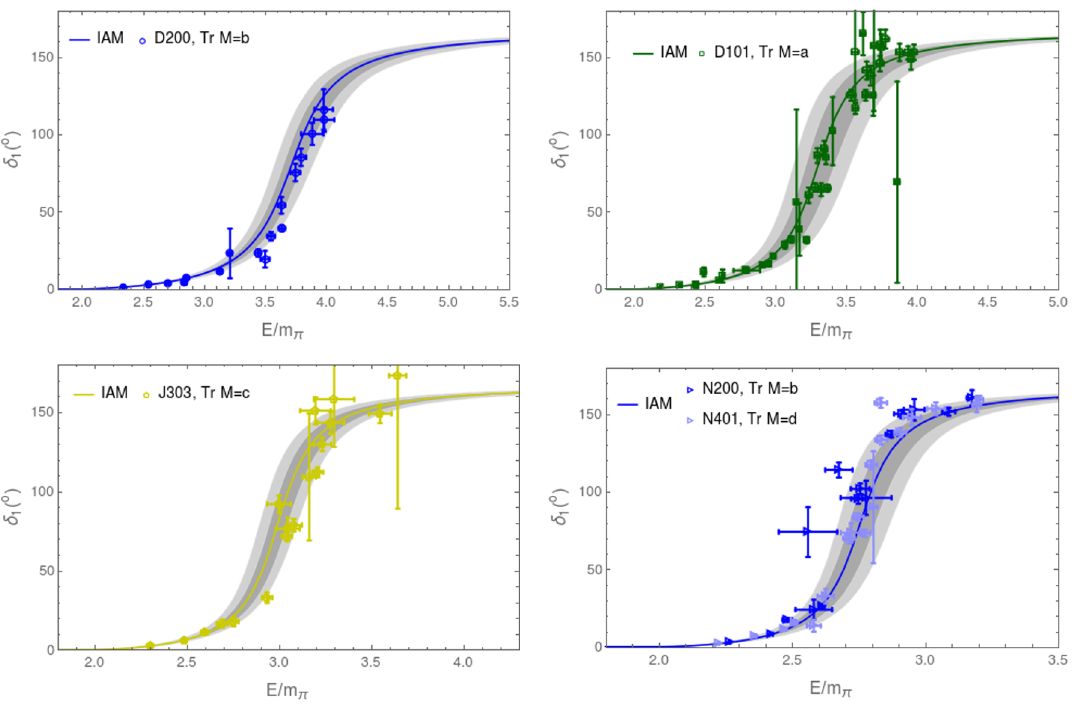
Figure 18 . Result of Fit IV in comparison with the Tr M = C data of the CLS ensembles, D200, D101, J303, N200 and N401 [81].